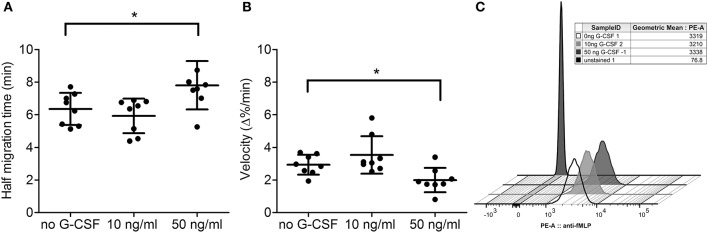
Systemic G-CSF treatment impairs chemotaxis in neutrophils from healthy donors. Purified neutrophils from peripheral blood of healthy, untreated donors (n = 8) were incubated with 0, 10, or 50 ng/ml human recombinant G-CSF. Thereafter, a chemotaxis assay was performed using fMLP as chemoattractant and half migration time (A) as well as velocity at half migration time (B) was determined. Neutrophils pre-treated with 0, 10, and 50 ng/ml of G-CSF respectively were stained with a PE-labeled anti-fMLP receptor antibody. The histogram is showing a representative experiment of three similar replications (C). Statistical analysis was performed with a Kruskal-Wallis test for (A) (p = 0.0098) and (B) (p = 0.0093), complemented with Mann-Whitney U-tests showing that samples 0 and 50 ng/ml are significantly different for (A,B) with *p < 0.05.